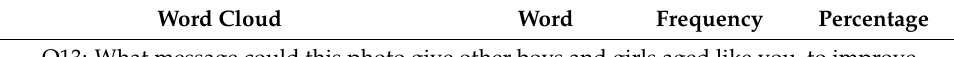
Table 5. Cont. Block 2: Most Comfortable Space. Word Clouds for Related Questions.